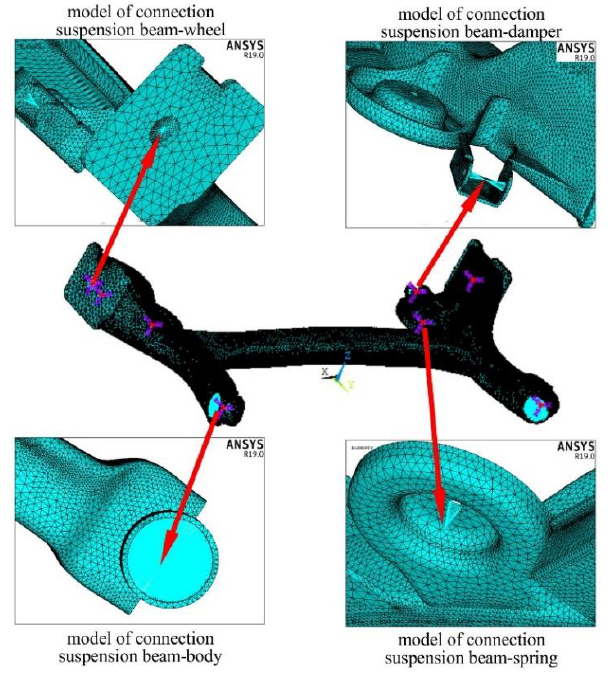
Figure 8. Location of the interface points. It is assumed that the exported suspension beam model contains 48 natural frequen- cies. The number of frequencies is limited to those which are the most important when determining the dynamic response of the system. Figure 9 shows the first two frequencies of free vibrations and the corresponding forms of vibrations. Analyzing the presented forms of vibration, it can be seen that the deformations associated with bending and torsion are dominant for the analyzed